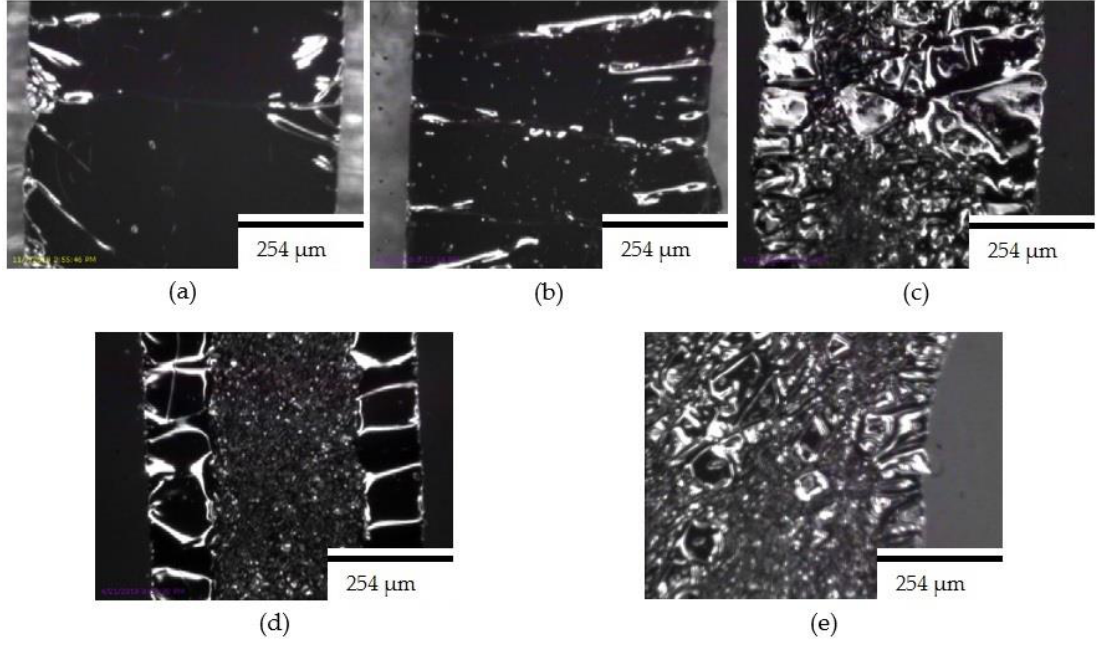
Figure 8. Microscopic images of conductive silver straight lines at various radial pre-stretching values: ( a ) 0%; ( b ) 10%; ( c ) 27%; ( d ) 30%; and ( e ) 35%.